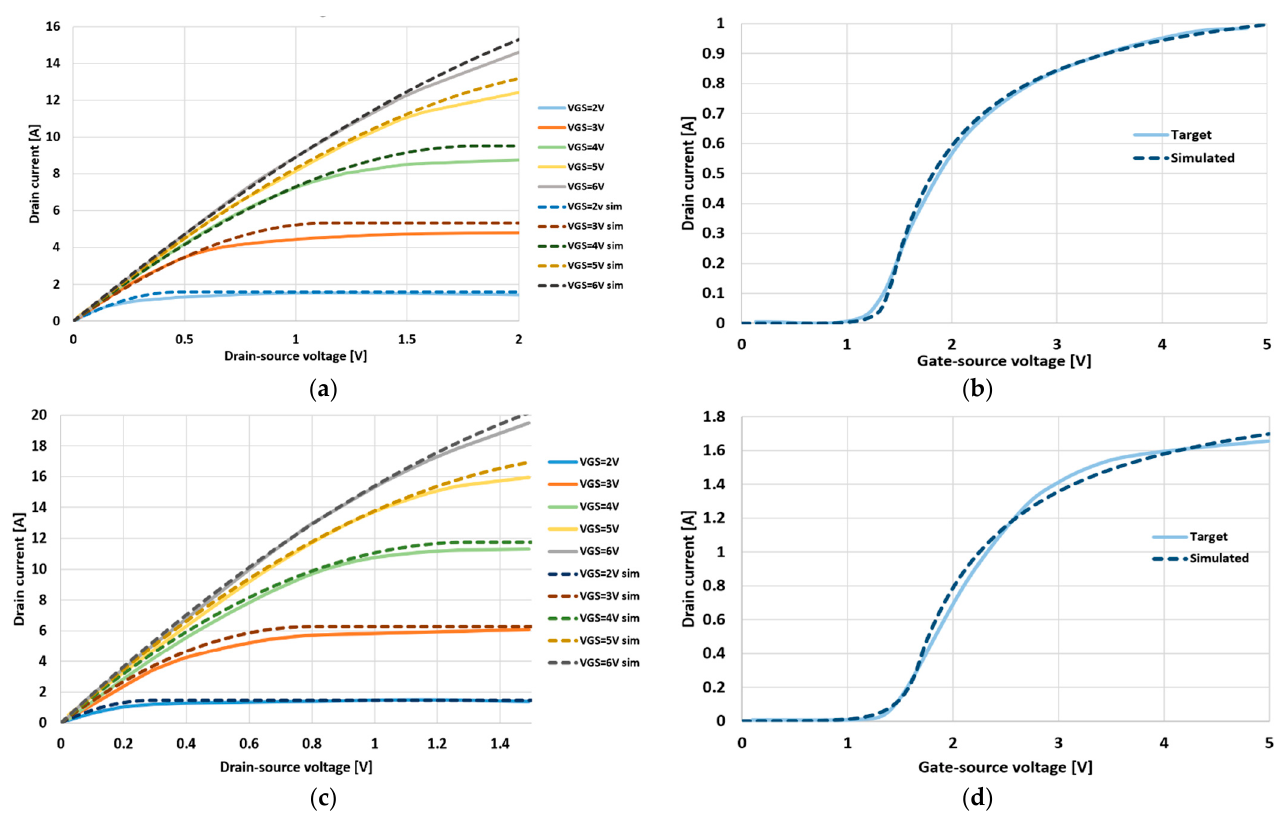
Figure 11. Comparison between target curves (solid lines) and simulated curves (dashed lines): ( a ) output characteristic of GS66504B [63]; ( b ) transfer characteristic of GS66504B [63]; ( c ) output characteristic of GS66506T [64]; ( d ) transfer characteristic of GS66506T [64].